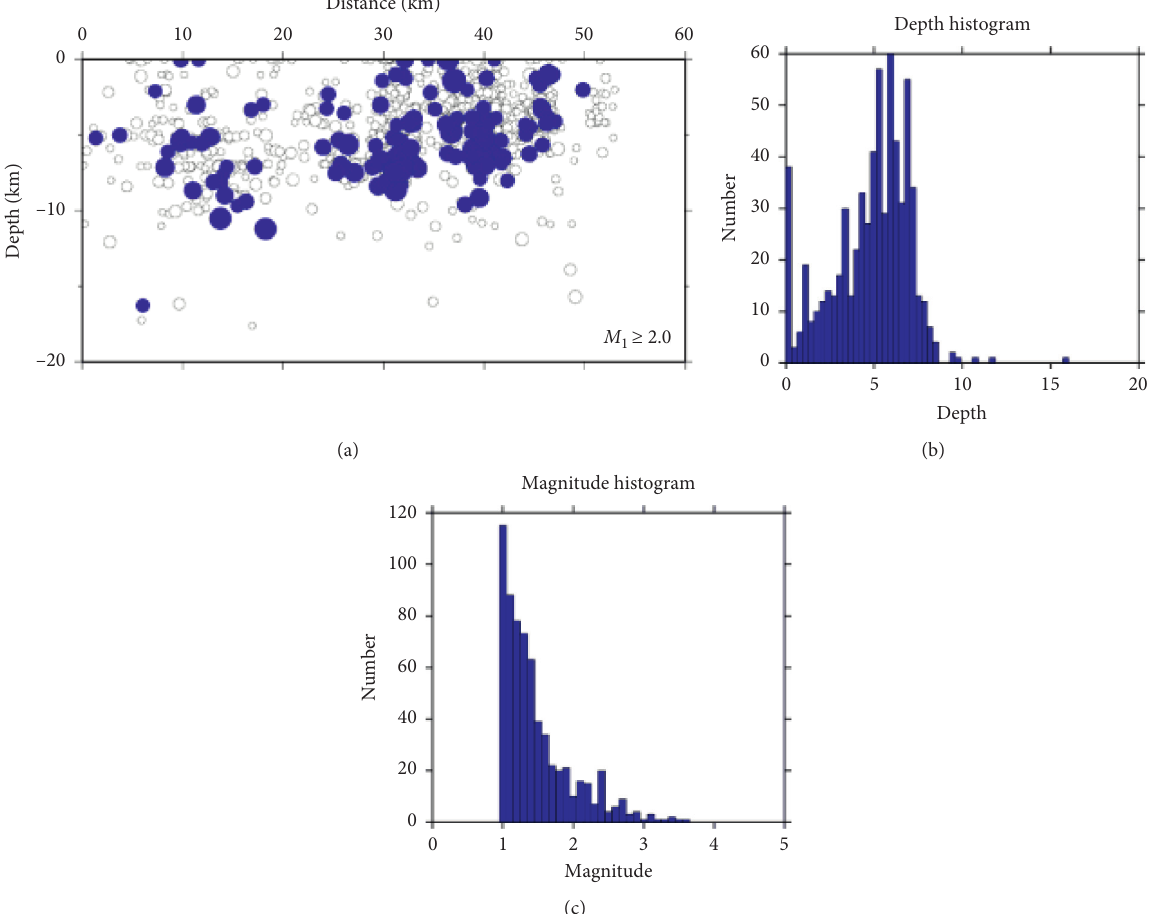
Figure 2: Earthquake statistics for the first reservoir tail and adjacent areas: (a) small earthquakes; (b) depth; (c)